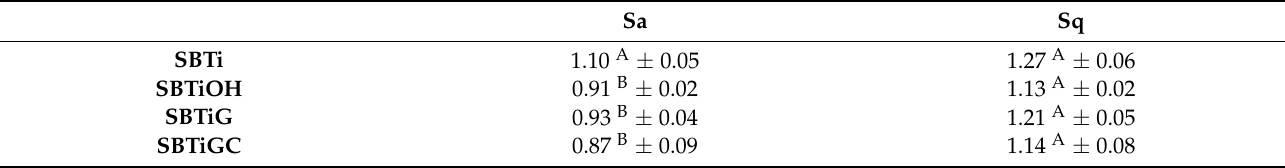
Table 1. Surface roughness of test samples presented as Sa and Sq ( µ m) (groups with different letters were significantly different ( p < 0.05).